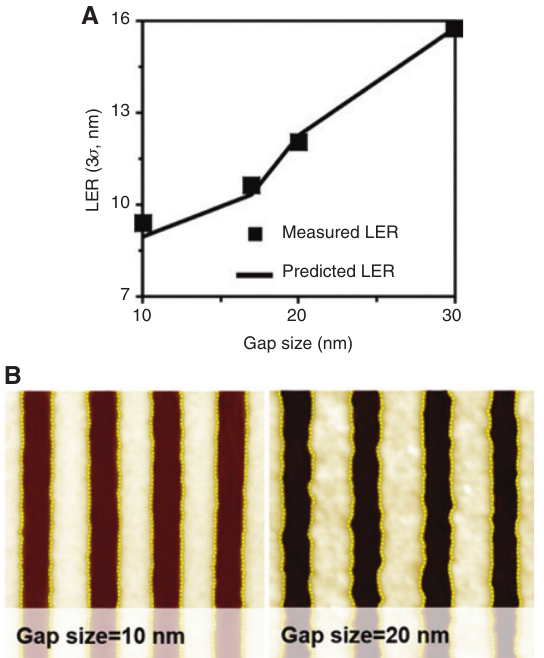
Figure 5: LER reduction by controlling the gap size. (A) Comparison results of the LER versus gap size between the (solid squares) measured and (solid line) predicted LERs. (B) AFM-measured profiles of the line patterns with a 100-nm top CD generated using two probes with gap sizes of 10 and 20